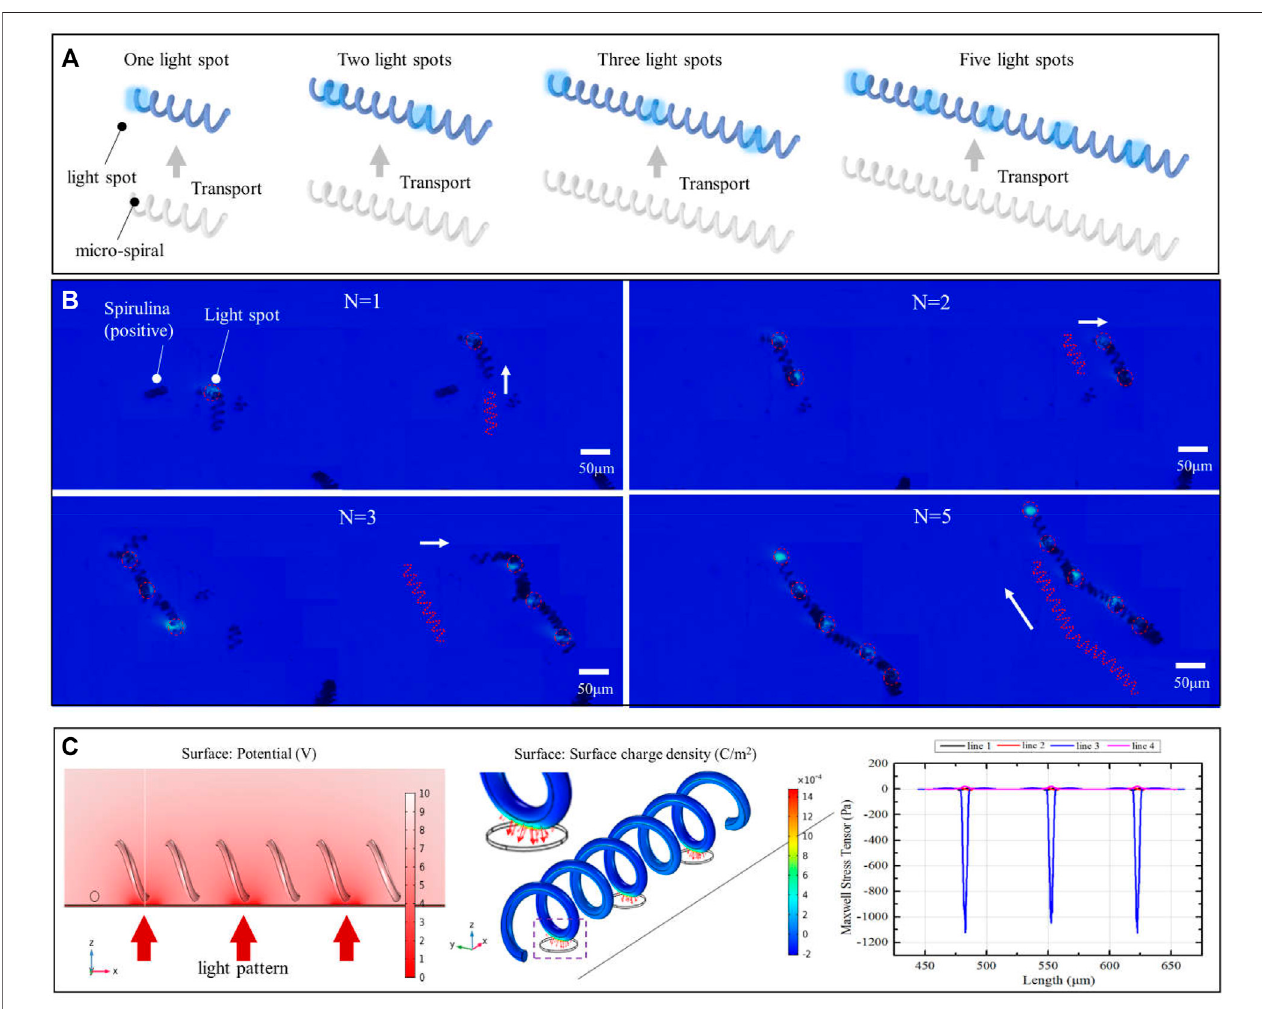
FIGURE 4 | Multiple light spots to collaboratively transport the different length micro- spirulina . (A) Schematic of manipulation and (B) experimental results (the number of light spots is 1, 2, 3, and 5, respectively). (C) Simulations of electric potential, surface charge density, and Maxwell stress tensor.